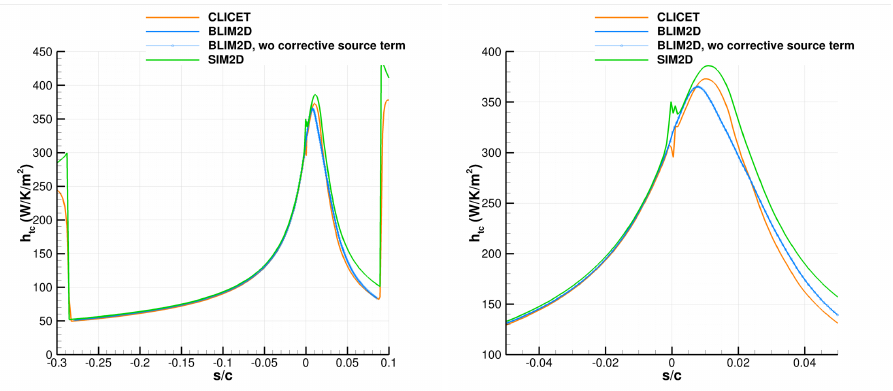
Figure A8. Solution produced by CLICET, SIM2D, and BLIM2D for the convective heat transfer coefficient h tc in Case 1 of Table A1. ( Left ): laminar area. ( Right ): focus in the vicinity of the stagnation point.